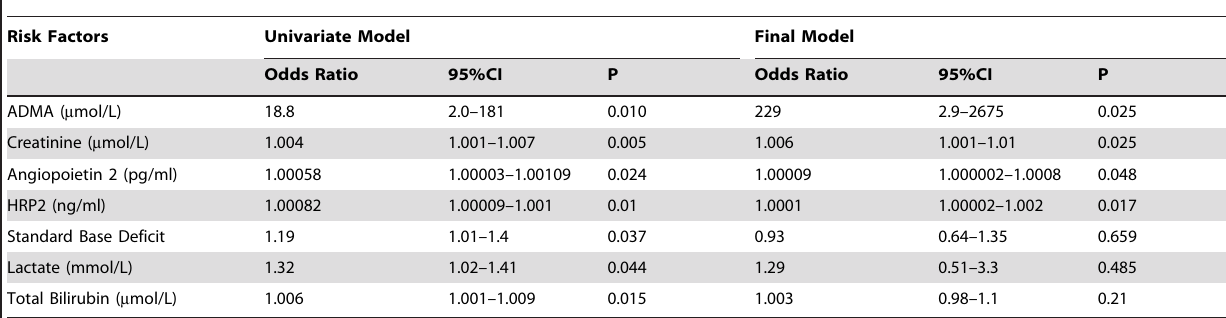
Table 4. Factors Associated with Death in Severe Malaria Patients.